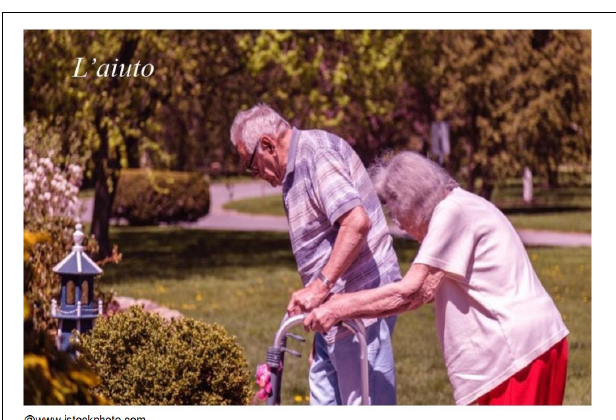
FIGURE 4 | Margherita’s chosen photograph and title: “The